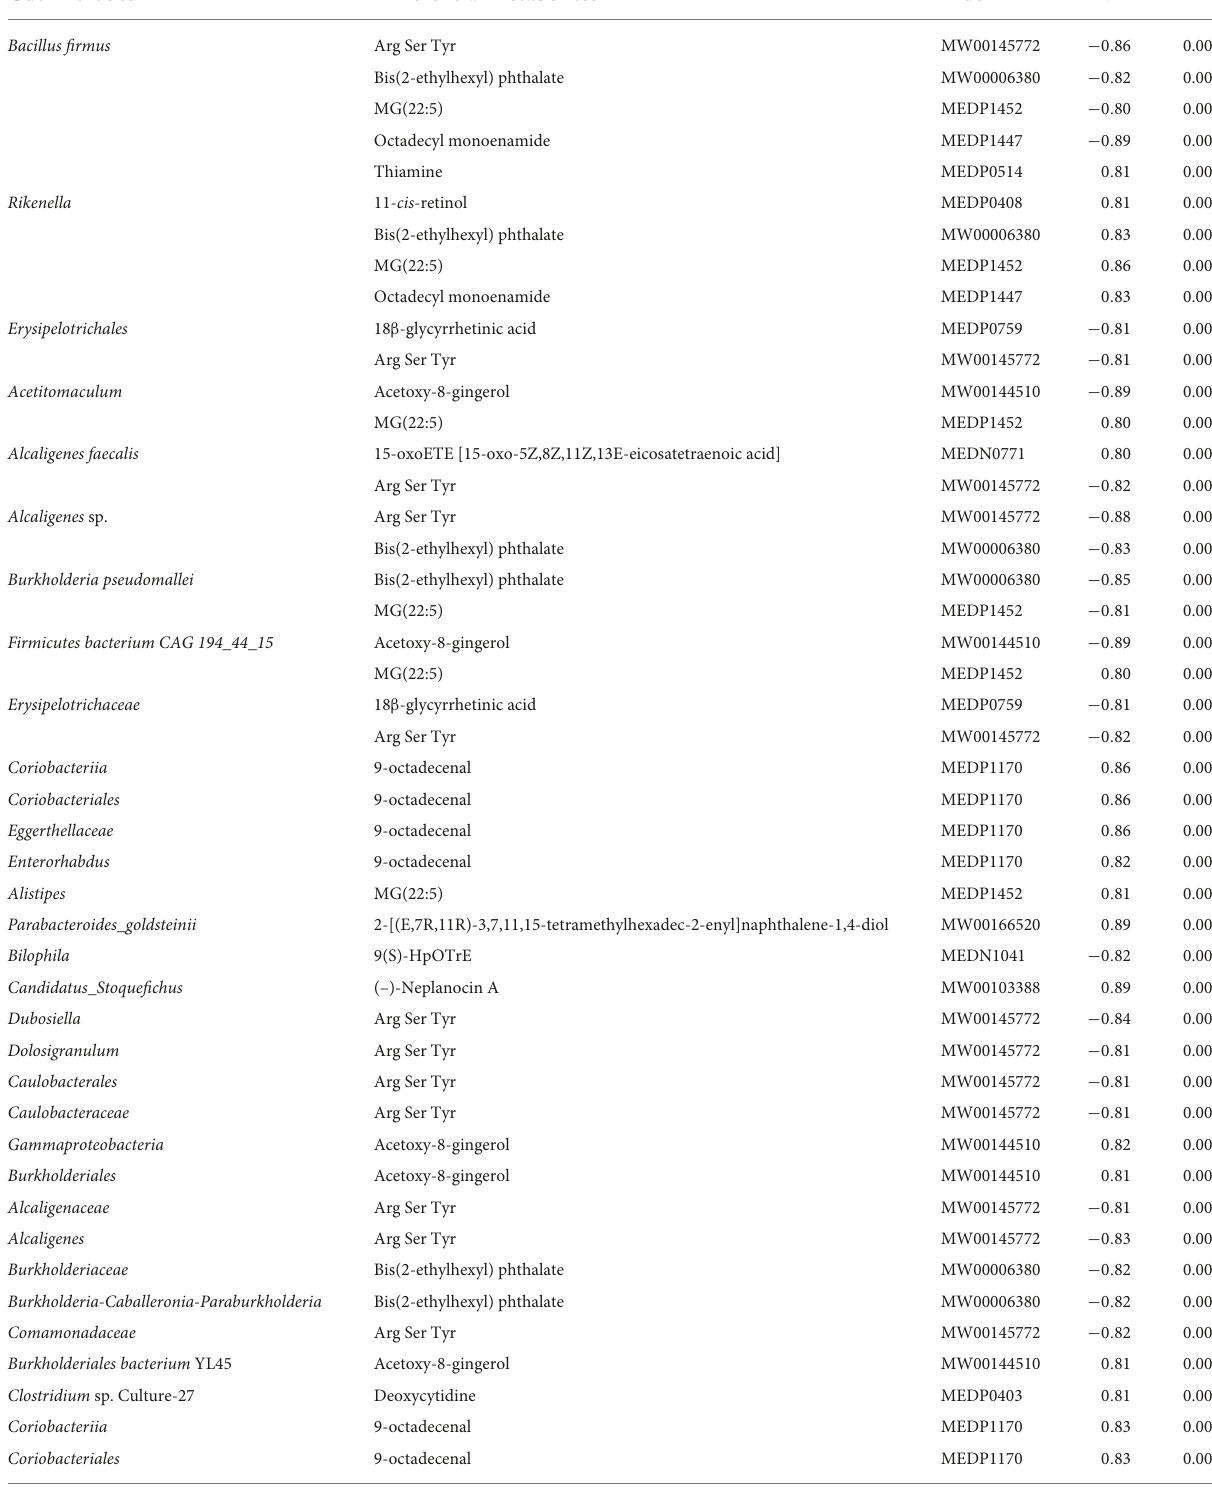
TABLE 2 Significant correlations between fecal metabolites and gut microbes. Gut